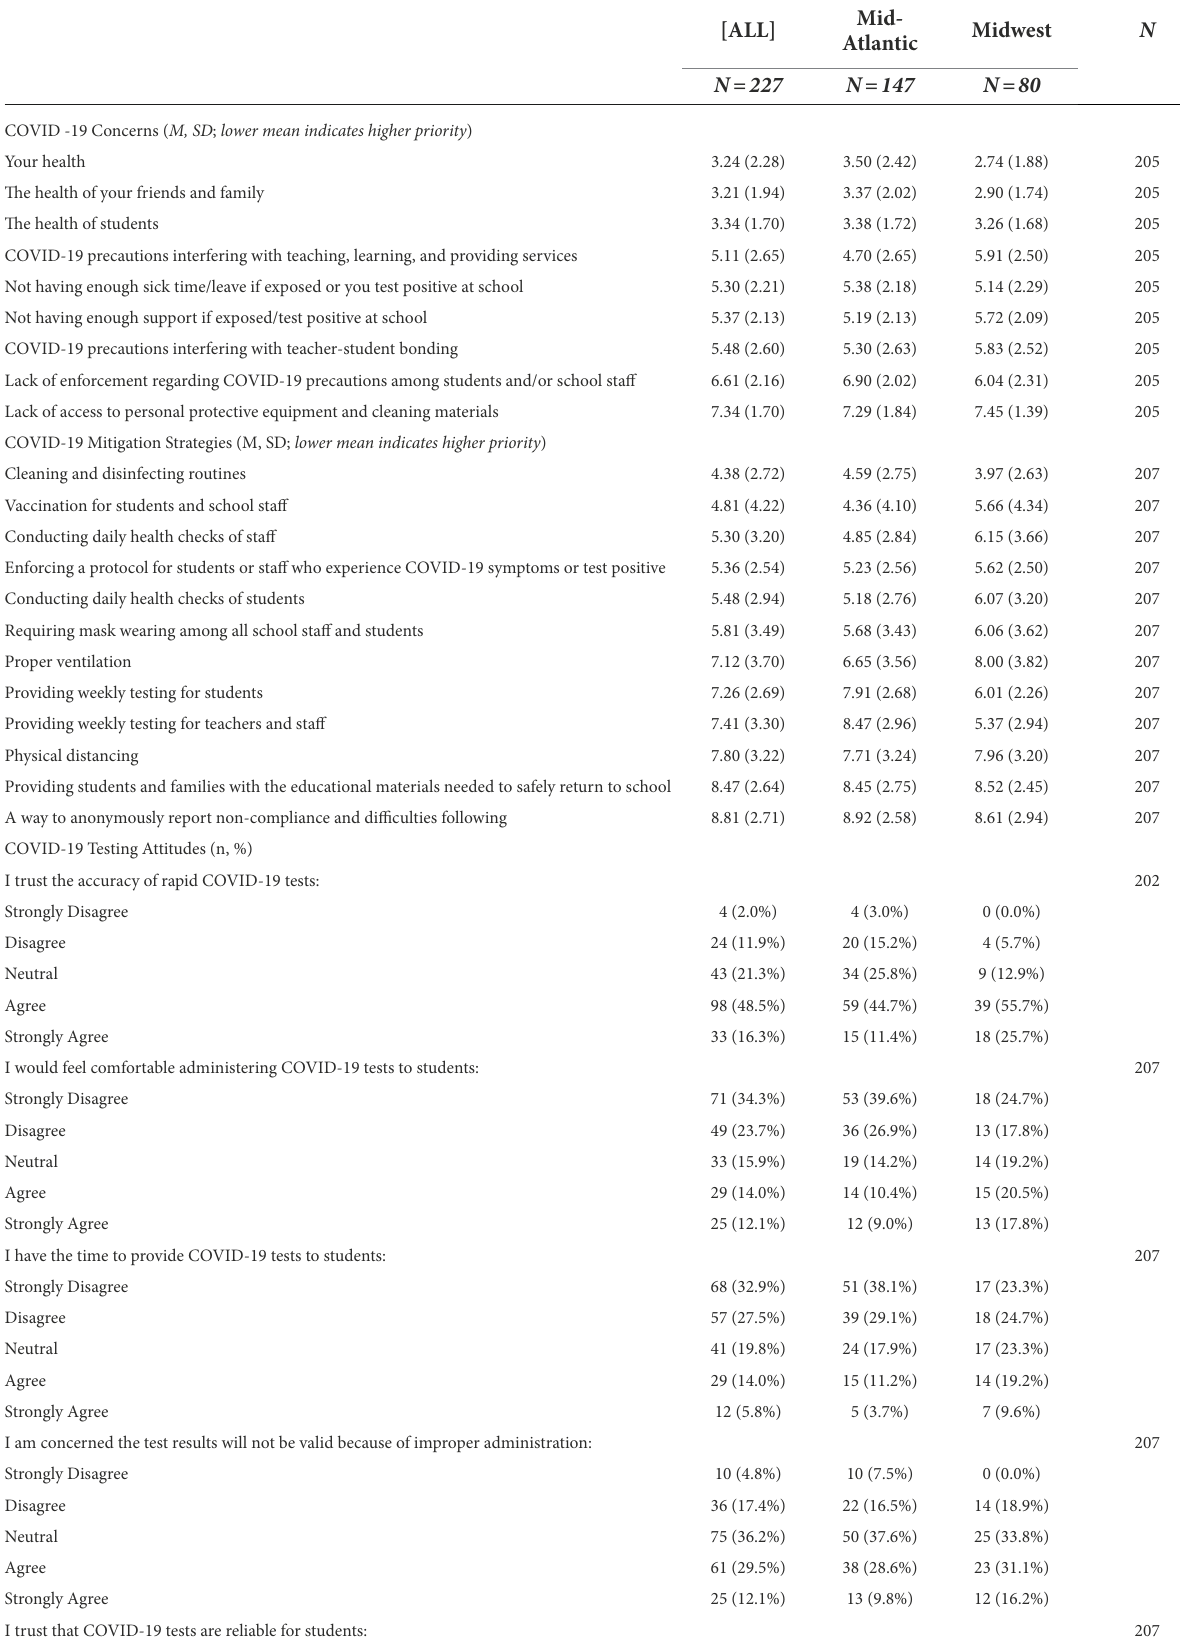
TABLE 2 Teacher concerns and attitudes about COVID